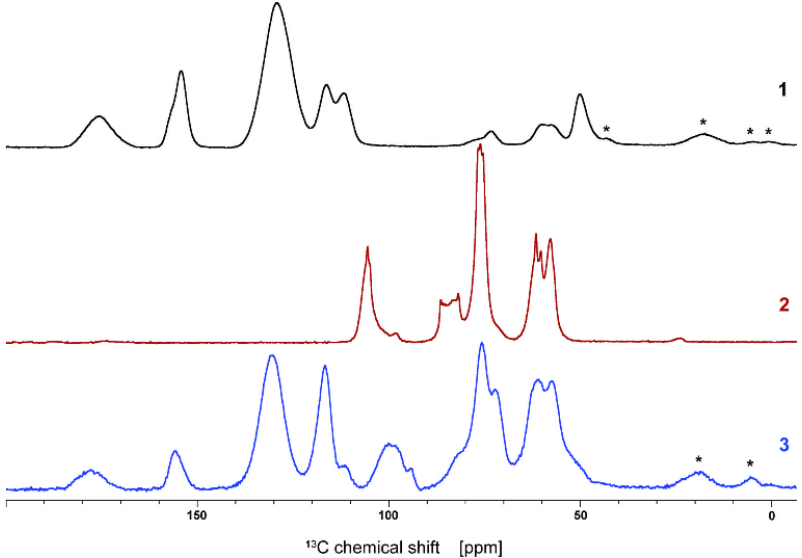
Figure 3. 13 C ss-NMR spectra of PBAAA (black), CHIT (dark red) and CHIT-PAAA (blue). The asterisk * indicates a sideband.